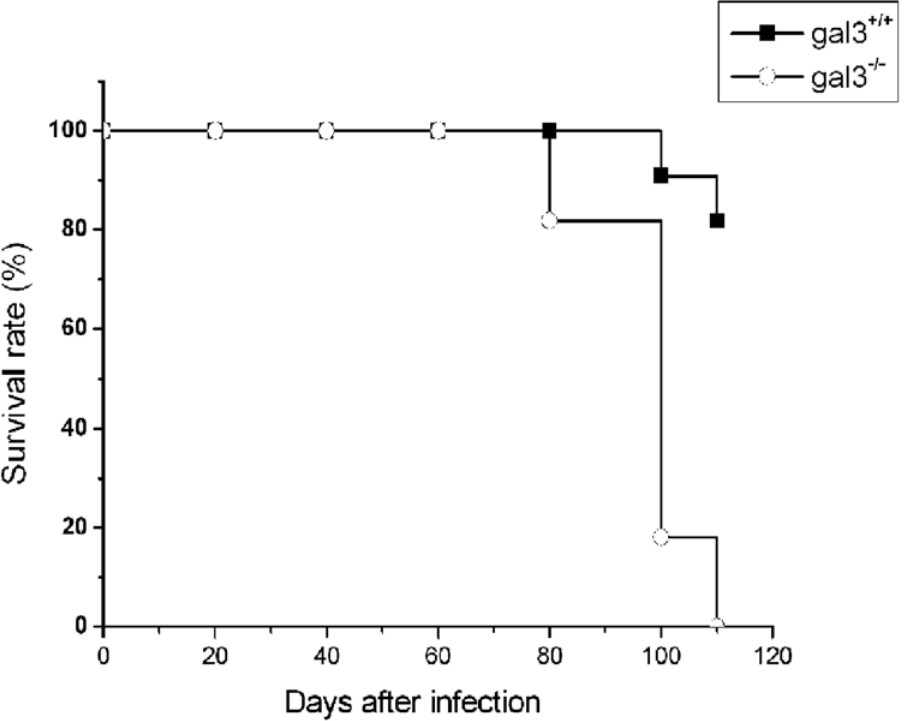
Figure 1. Absence of galectin-3 leads to lower survival in mice infected by P.brasiliensis . The survival rate of gal3 + / + (black squares) and gal3 2 / 2 (open squares) mice after intraperitoneal infection with 5 6 10 6 yeasts cells (P , 0.0001, compared with infected gal3 + / + mice.). Data are representative of two experiments, each performed with eight to ten mice per group.